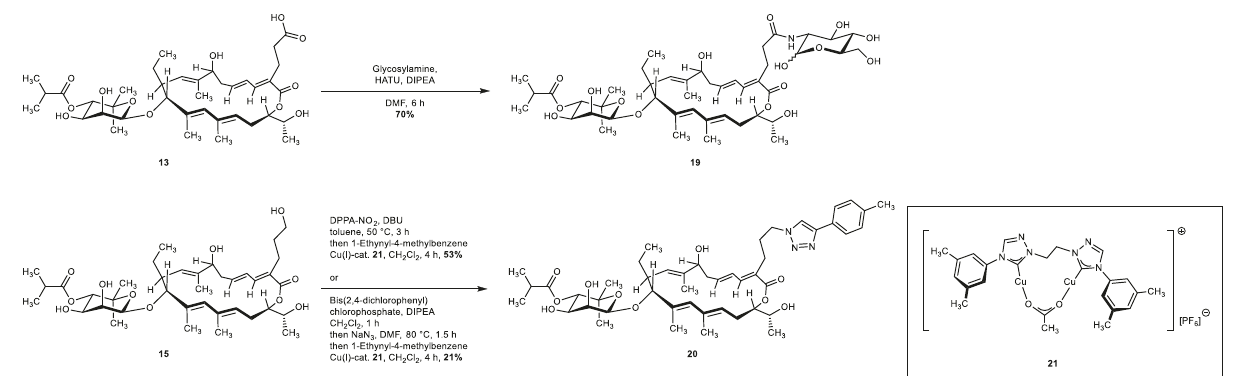
Fig. 12 Functionalization of C2-elongated carboxylic acid 13 and alcohol 15. Synthesis of glucosamide- fi daxomicin 19 and triazol 20 . HATU 1-[Bis (dimethylamino)methylene] − 1H-1,2,3-triazolo[4,5-b]pyridinium 3-oxide hexa fl uorophosphate, DPPA-NO 2 Di-(nitrophenyl)phosphoryl